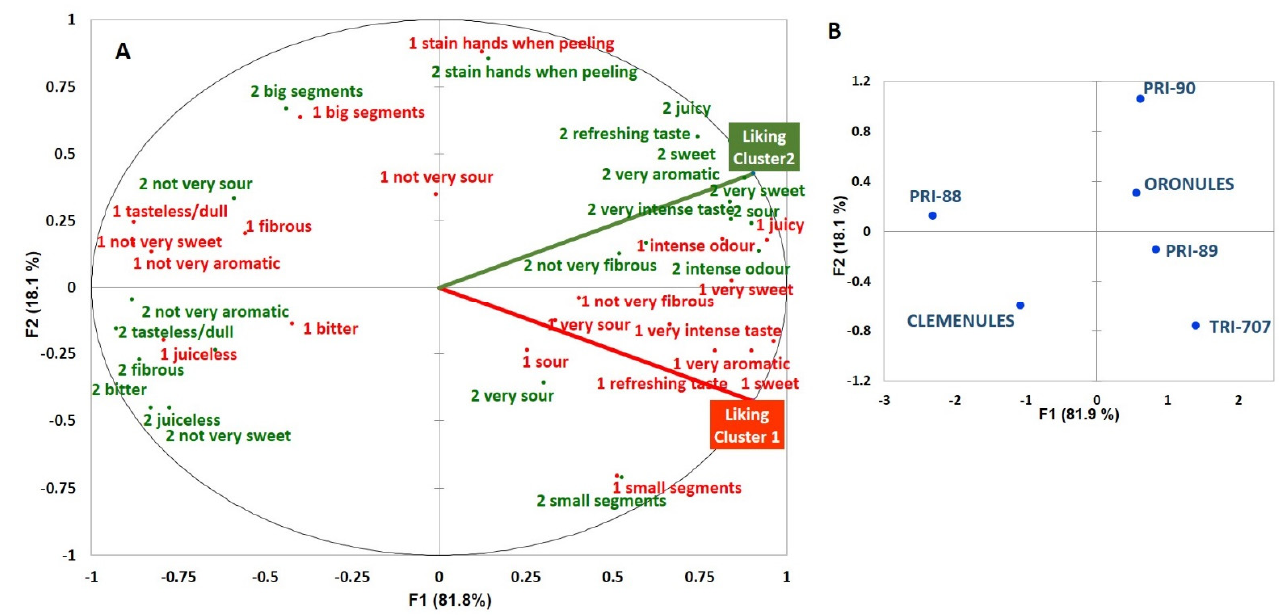
Figure 3. MFA of the CATA question considering liking scores for each of the two identified clusters as active datasets and attributes selected to describe samples and ideal as Supplementary Data. ( A ) Vocabulary and liking (Cluster 1: red font; Cluster 2: green font). ( B ) Samples representation.